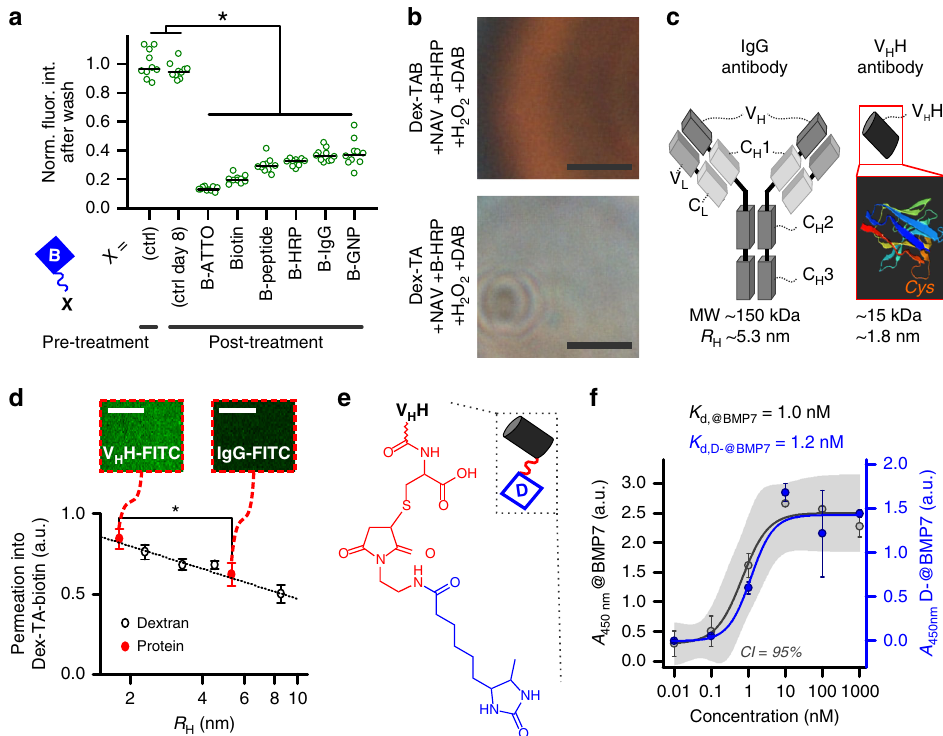
Fig. 4 Competitive supramolecular displacement by distinct biotinylated moieties. a The universal nature of competitive complexation of desthiobiotinylated and biotinylated moieties with neutravidin was demonstrated by displacing D-FITC coupled to Dex-TAB by a variety of biotin-modi fi ed compounds indicated with “ X ” and ranked by their hydrodynamic radii ( R H,B-ATTO = 0.7 nm, R H,B-GNP = 10nm). “ ctrl ” indicates treatments with PBS. Asterisk indicates signi fi cance ( p < 0.01; one-way ANOVA with Tukey ’ s post hoc test on normally distributed data as indicated by Shapiro-Wilk p > 0.1). b Supramolecularly complexed HRP enzymes remained bioactive as con fi rmed by the formation of brown precipitate upon addition of DAB staining solution in the presence of H 2 O 2 . B-HRP could not be supramoleculary complexed to pristine Dex-TA. c Single-domain (V H H) antibodies are an order of magnitude smaller than conventional (IgG) antibodies. d The relatively small hydrodynamic radius ( R H ) of V H H-type antibodies signi fi cantly improved their penetration into Dex-TAB as compared to IgG-type antibodies. Error bars indicate±standard deviation ( n = 4). Asterisk indicates signi fi cance ( p < 0.05; Mann – Whitney). e Schematic depiction of desthiobiotinylated BMP7-binding V H H (D-@BMP7). f D-@BMP7 did not have a signi fi cantly different af fi nity for BMP7 as compared to the pristine BMP7- binding V H H (@BMP7) as con fi rmed by the dose-response curve of the D-@BMP7 (i.e., blue) that fi ts within the 95% con fi dence interval (CI) of @BMP7 ’ s dose-response curve (i.e., gray). Error bars indicate±standard deviation ( n = 3). All scale bars indicate 10 µ neutravidin than D-@BMP7 (Fig. 5d and Supplementary Table 1),